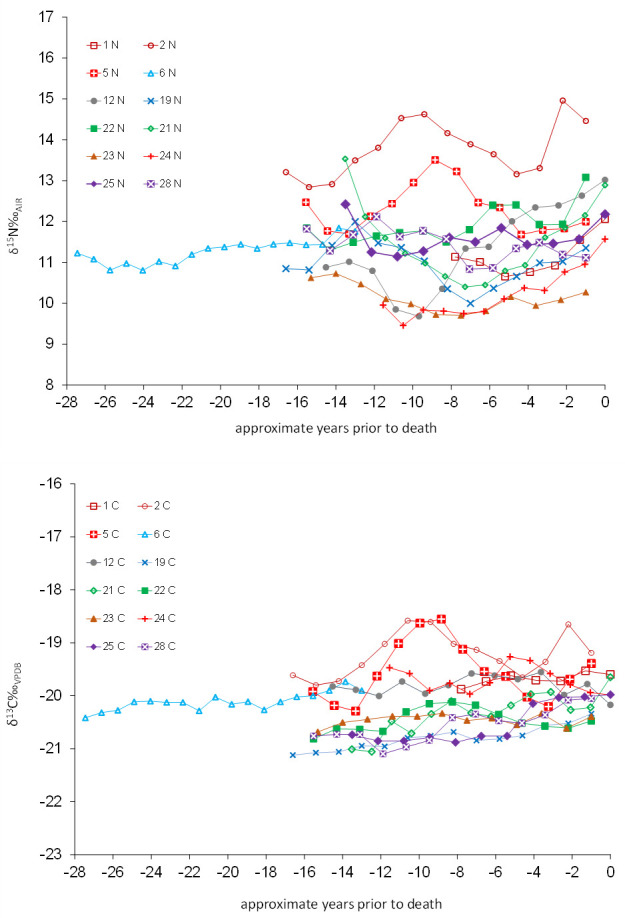
M3 isotope profiles by approximate age of formation (a) δ15N, (b) δ13C.